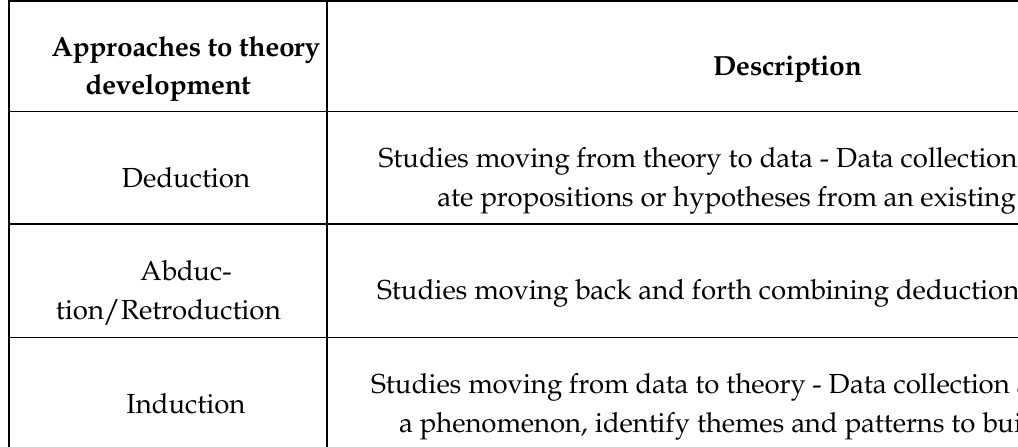
Table 3: Approaches to theory development Approaches to theory